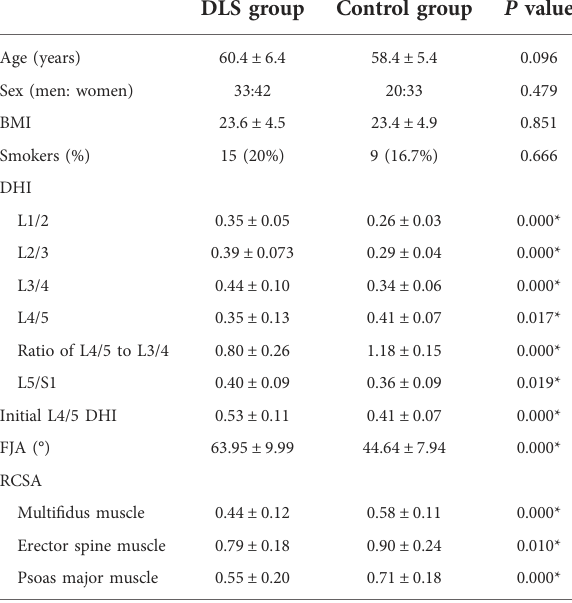
TABLE 3 Correlation between initial L4/5 DHI and lumbosacral sagittal parameters.